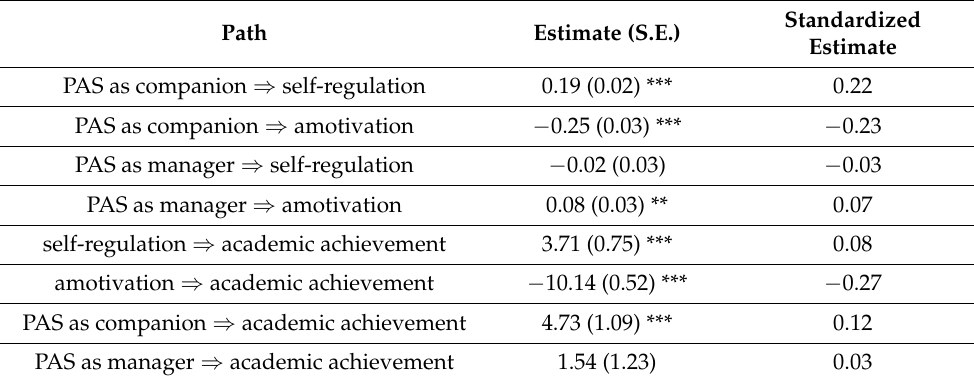
Table 4. Path Coefficients of PAS and Adolescent Psychological